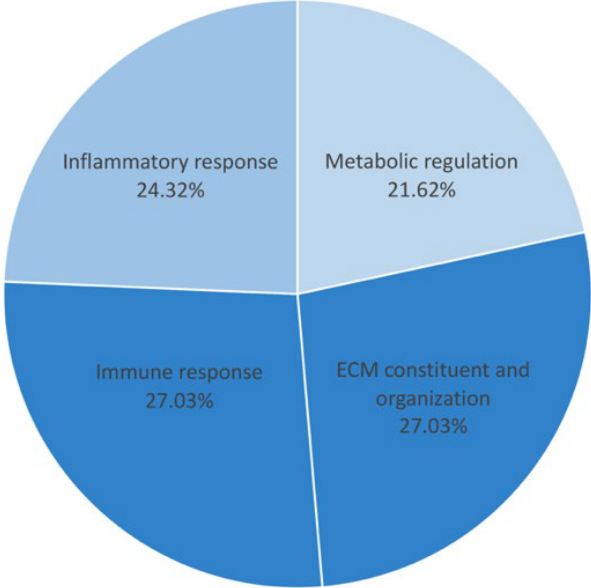
Figure 3. The percentage of proteins in 4 major pathways. The metabolic regulation pathway was 21.62%; the inflammatory response pathway was 24.32%; the immune response and ECM constituents and organization pathway were 27.03%.